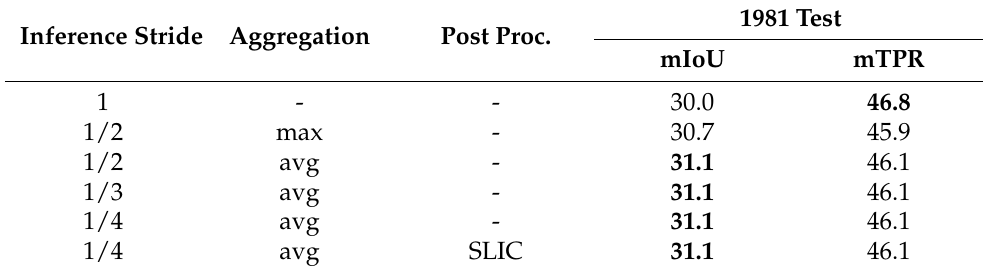
Figure 10. ( A ) Part of the Sagalassos 1981 orthophoto, with ( B ) corresponding predicted LULC map using no overlap during inference, ( C ) using a relative stride of 1/4th of the patch size during inference, and ( D ) combining the latter with SLIC post processing. Table 7. Summary of semantic segmentation results on the Sagalassos 1981 test set for various inference strides relative to the patch size with either average (avg) or maximum (max) aggregation, and for the combination with SLIC post